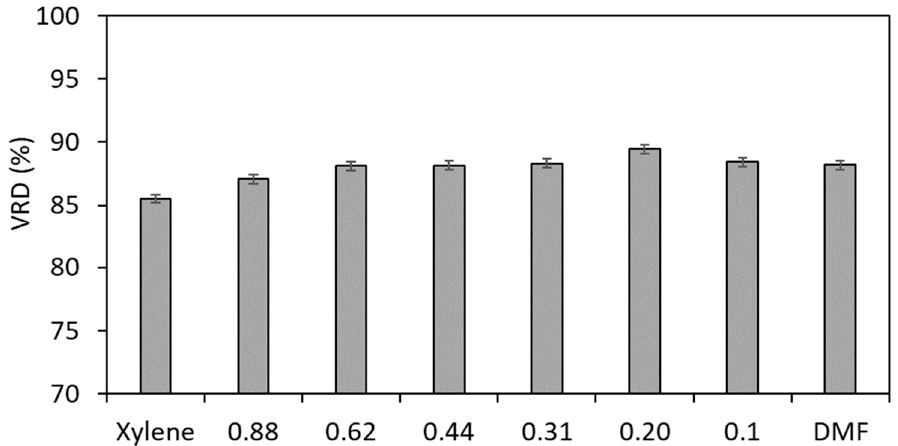
Figure 5. Effect of xylene/dimethylformamide (DMF) ratio in the viscosity reduction degree (VRD) of an extra ‐ heavy oil (EHO) at 30 °C for a fixed nanofluid dosage of 5 vol % at a fixed shear rate of 10 s − 1 . S9 nanoparticles were dispersed in the carrier fluid to accomplish a concentration of 1000 mg ∙ L − 1 regarding the